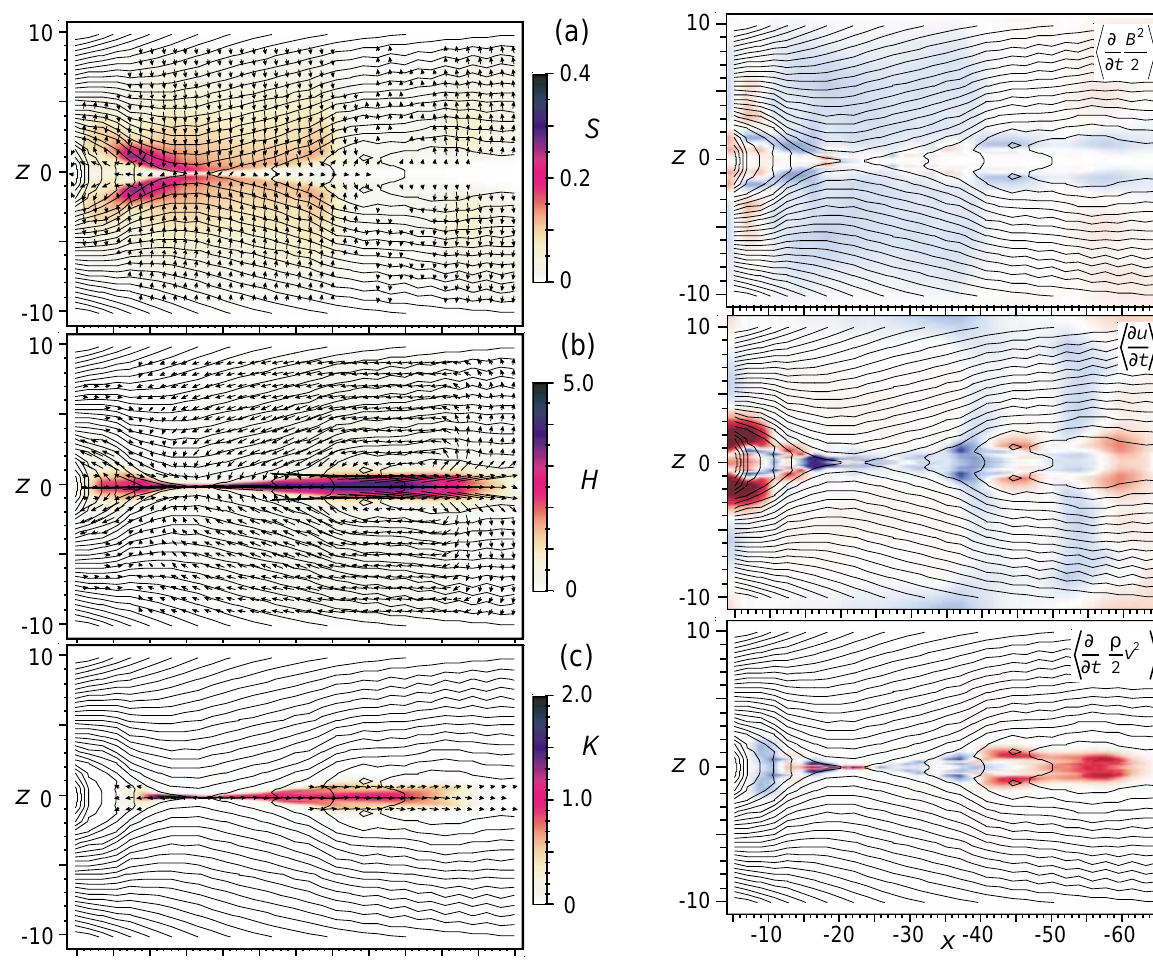
Fig. 3. Change of energy densities, integrated over y : (a) magnetic energy, (b) thermal energy, and (c) kinetic energy